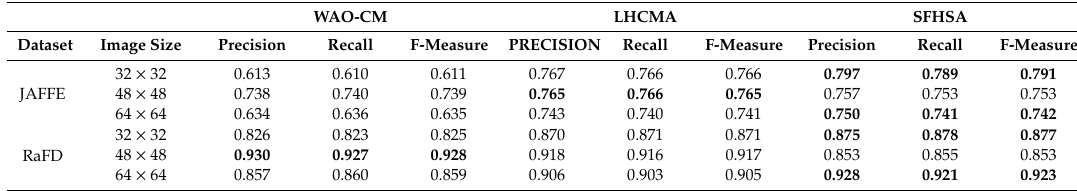
Table 8. Performance of SFHSA with respect to WAO-CM and LHCMA for uLBP features in terms of Precision, Recall and F-measure.